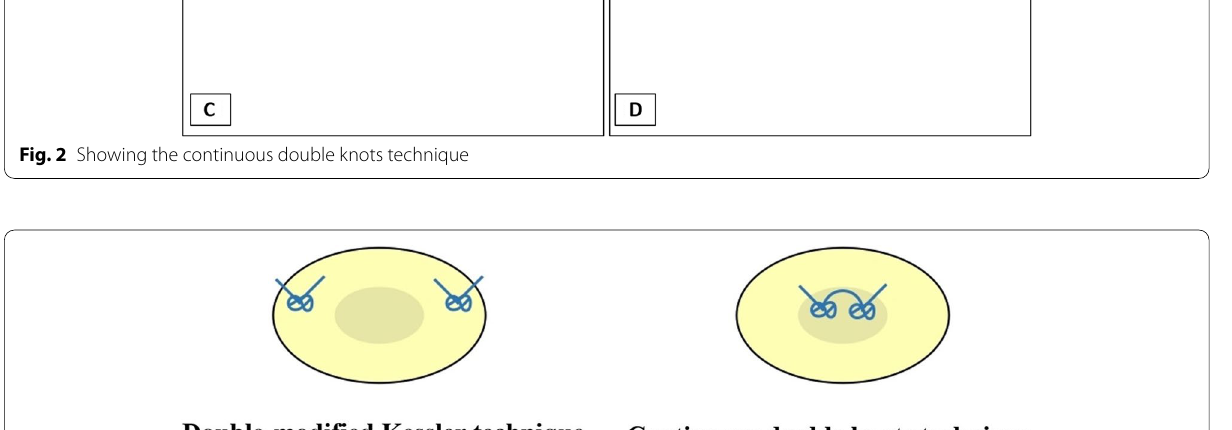
Fig. 3 Showing the comparison of cross sectional of flexor tendon after repair by two 4-core suture